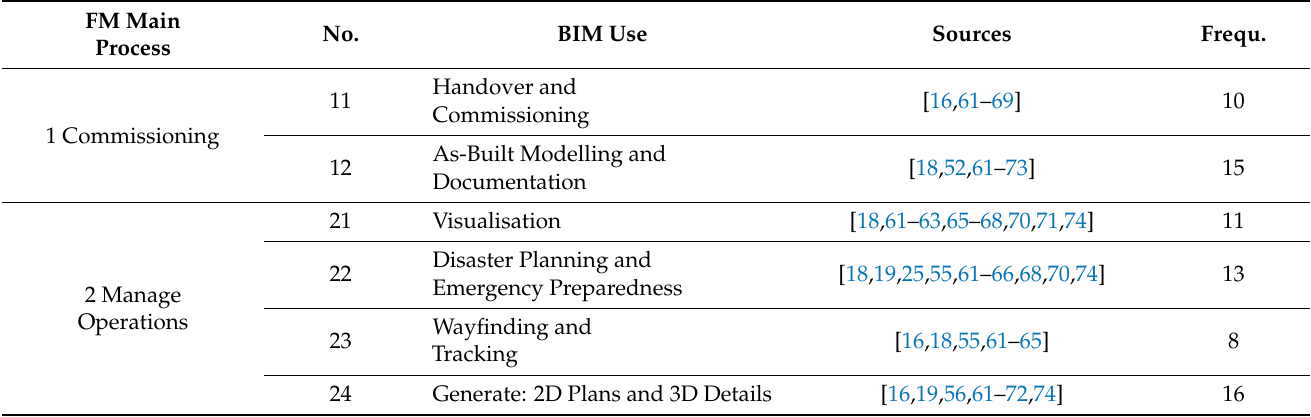
Table A1. Identified BIM uses for FM in CREM—FM main processes, sources, and